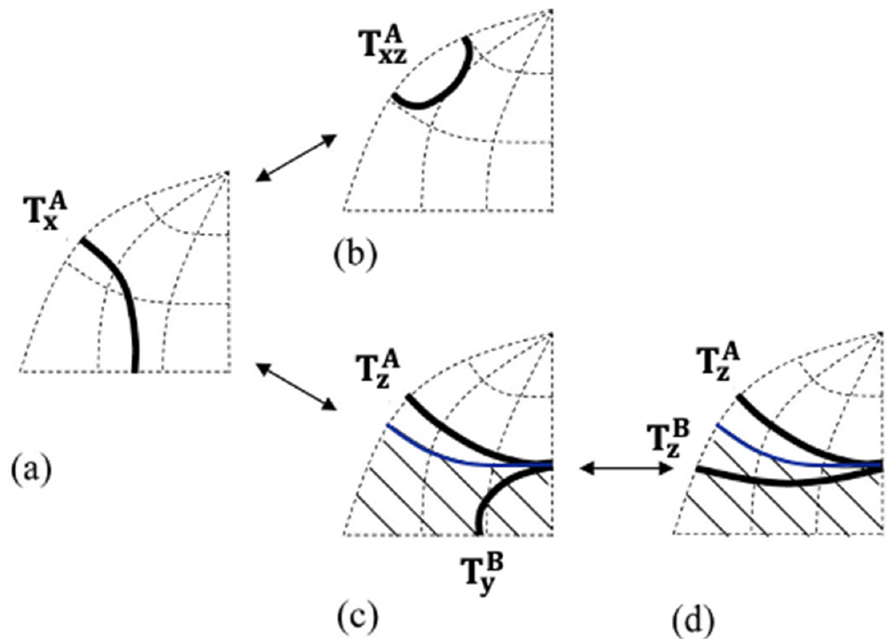
(cid:0) (cid:1) T A x , T A xz , T A z Figure 4. Topologies of scheme-A ( ∆ k ( θ , φ ) > 0 ) AQPM solutions and scheme-B Figure 4. Topologies of scheme-A (Δ𝑘(𝜃,𝜙) > 0) AQPM solutions (𝑇 (cid:3051)(cid:3002) ,𝑇 (cid:3051)(cid:3053)(cid:3002) ,𝑇 (cid:3053)(cid:3002) ) and scheme-B (cid:16) (cid:17) (Δ𝑘(𝜃,𝜙) < 0) AQPM solutions (cid:3435)𝑇 (cid:3052)(cid:3003) ,𝑇 (cid:3053)(cid:3003) (cid:3439) in uniaxial periodically poled crystals. (a–b) Paths of con- ( ∆ k ( θ , φ ) < 0 ) AQPM solutions T B y , T B z in uniaxial periodically poled crystals. ( a – d ) Paths of tinuous evolution with spectral dispersion of the AQPM solutions and associated topologies. The blue lines depict the circular cones of BPM (Δ𝑘(𝜃,𝜙) = 0) solutions, which corresponds to bound-